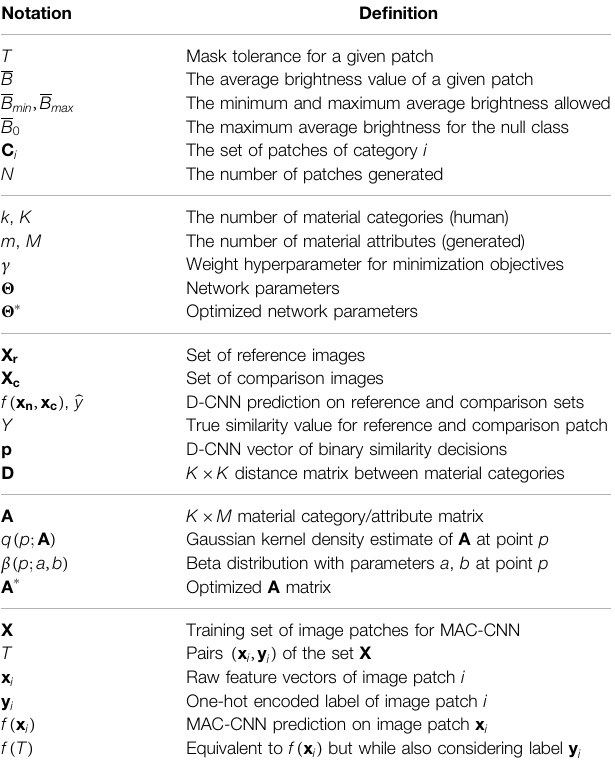
TABLE 1 | Summary of